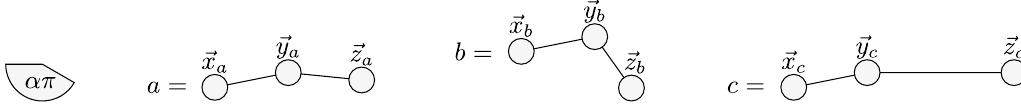
Figure 5. An example of (α , ε) -aligned triples. Let α and ε be as shown on the left. Then, the triple a = ( � x a , � y a , � z a ) is (α , ε) -aligned, the triple b = ( � x b , � y b , � z b ) is not (α , ε) -aligned (the angle formed by (cid:31) x b and (cid:31) z b with respect to (cid:31) y b is smaller than απ ), and the triple c = ( � x c , � y c , � z c ) is also not (α , ε) -aligned (the distance between (cid:31) y c and (cid:31) z c is larger than ε